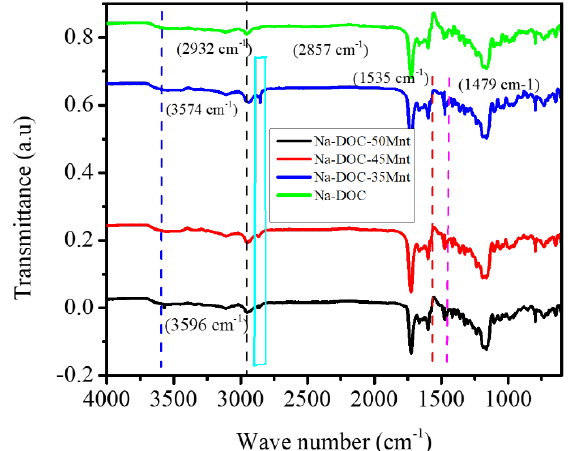
Figure 5. FTIR spectra of pure sodium deoxycholate (Na-DOC) and gels with 60 mmole L − 1 Na-DOC and 35, 45 and 50 mmole L − 1 concentration of Mnt / NaCl (1:1 mmole L − 1 concentration ratio of Mnt / NaCl